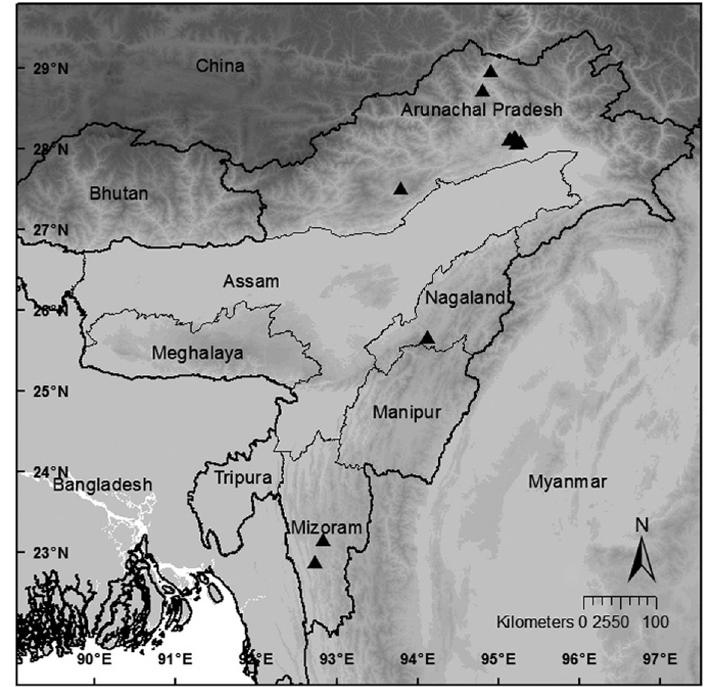
Fig. 10. Map showing the location of B. annulata K.Koch